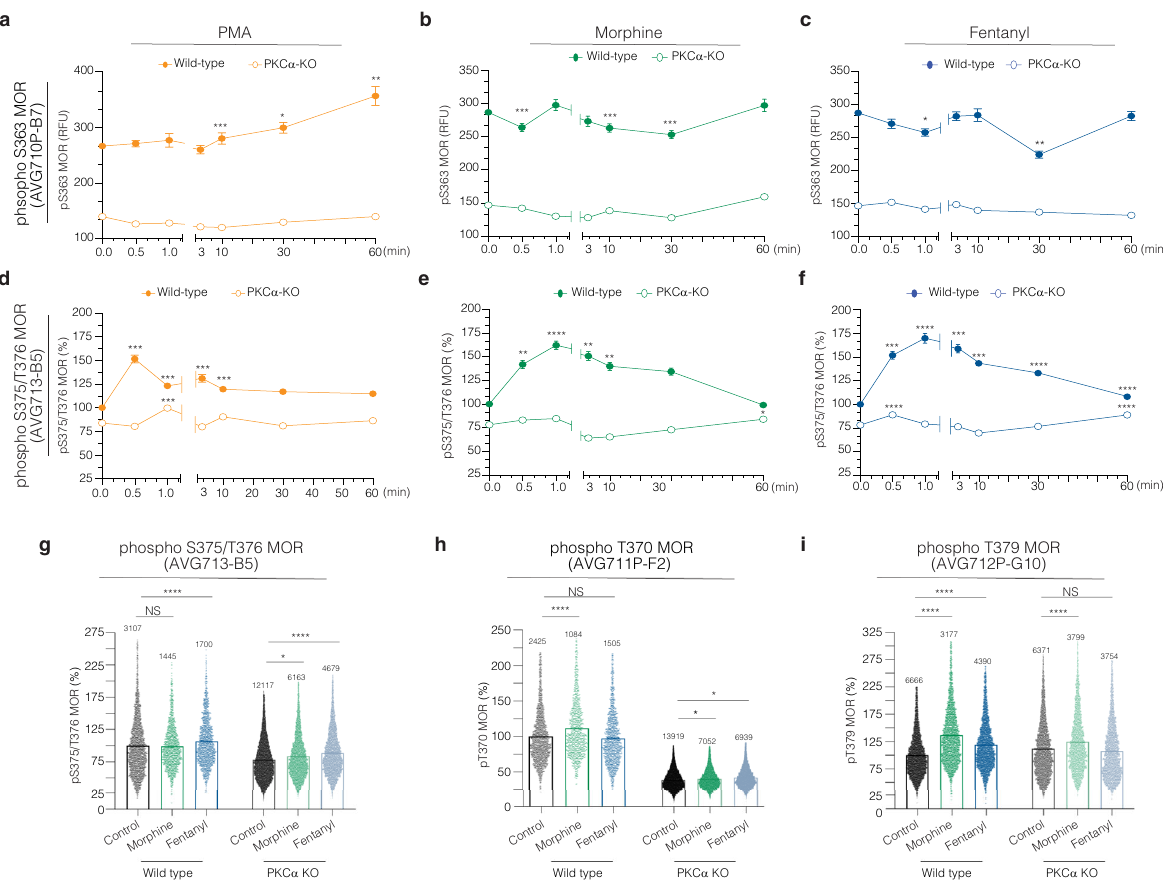
Fig. 7 Dynamics of MOR C-terminus phosphorylation. Neuro2A and Neuro2A PKC α -KO cells were treated with PMA ( a , d ), morphine ( b , e ), or fentanyl ( c , f ) for different time intervals, and probed with anti-phospho S363 MOR (AVG710P-B7) ( a – c ) and anti-phospho S375/T376 MOR (AVG713-B5) ( d – f ) antibodies. Images were acquired with the InCell microscope, and the fl uorescence intensity was obtained using the CellPro fi ler 3.1.5 software. Data are mean ± SE of two experiments n = 150 – 3000 cells. * p value < 0.01; *** p value < 0.001; **** p value < 0.0001; One-way ANOVA. g – i Neuro2A and Neuro2A PKC α -KO cells were treated with morphine and fentanyl for 1 h and probed using anti-phospho S375/T376 MOR ( g ), anti-phospho T370 MOR (AVG711P- B6) ( h ), and anti-phospho T379 MOR (AVG712P-G10) ( i ) antibodies. Bar graph, each dot represents one cell. Lines are mean ± SE of two experiments, number of counted cells are indicated. The percentage analysis used the mean of the integrated fl uorescence intensity from the non-treated Neuro2A cells as 100%. NS non-signi fi cant; * p value < 0.05; *** p value < 0.001; **** p value < 0.0001; One-way ANOVA.